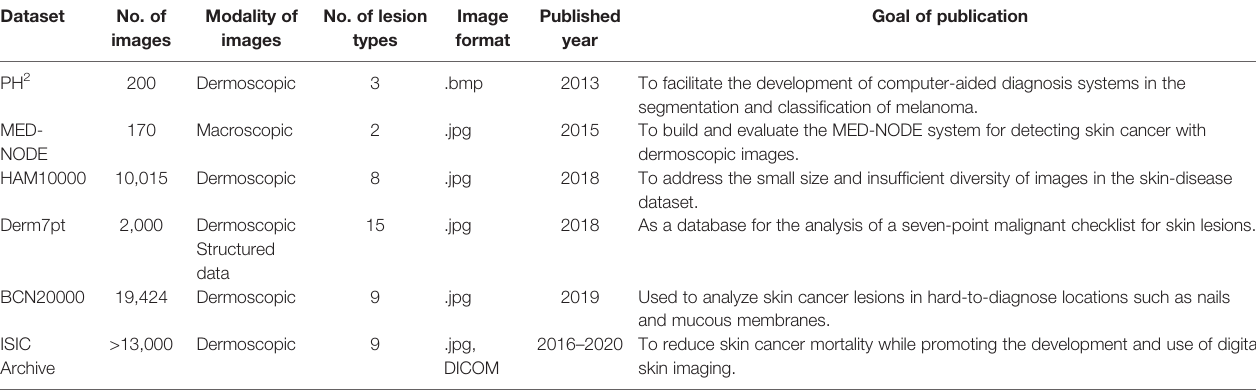
TABLE 2 | Characteristics of different skin-disease